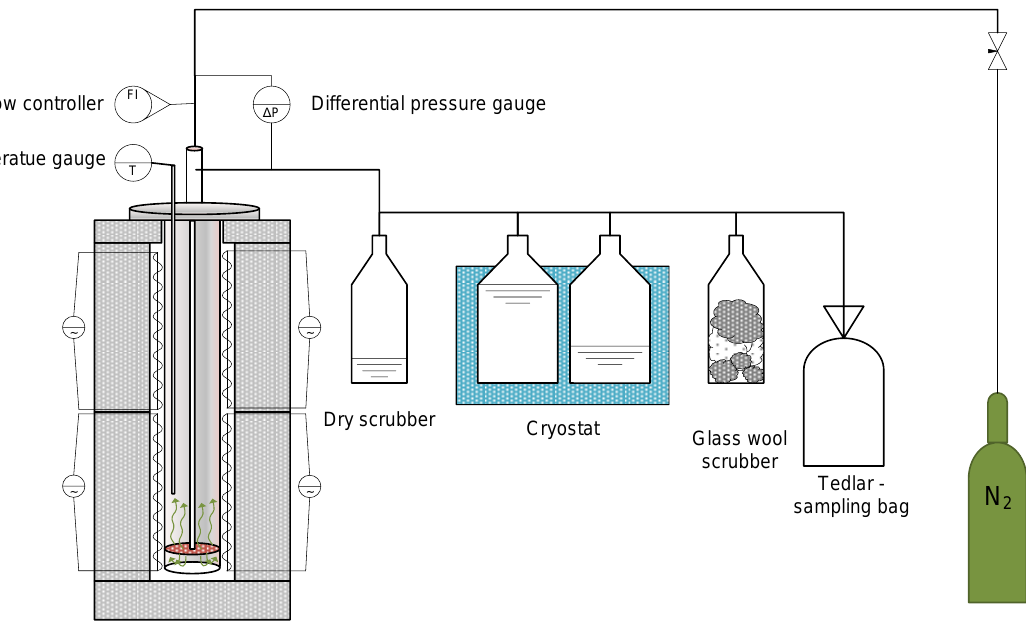
Figure 1. The test set up for pyrolysis of biomass waste samples in a fixed-bed reactor.